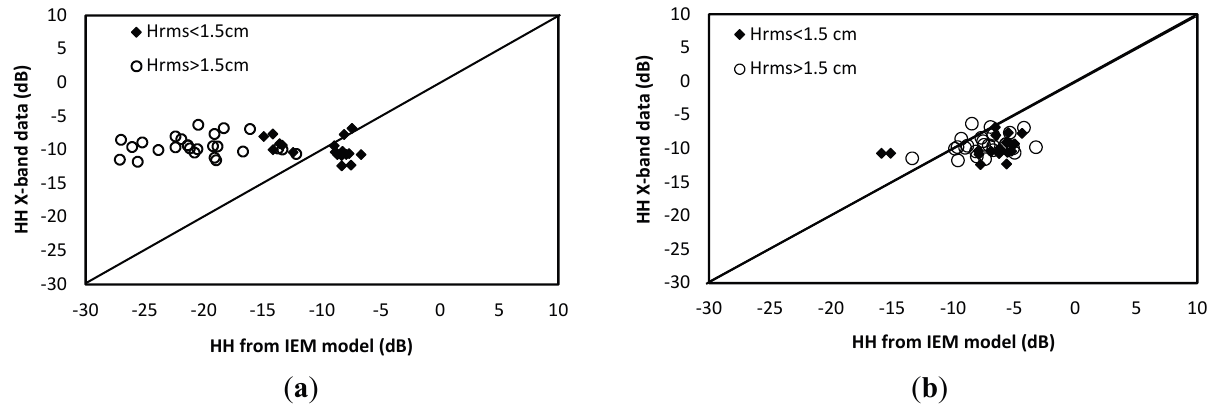
Figure 9. Comparison between measured X-band data and IEM simulations at 26° incidence in the HH polarization: ( a ) exponential correlation surface; ( b ) Gaussian correlation function. Using X-band data and various incidence angles in the range between 25° and 52°, Baghdadi et al. , [30] observed that the IEM correctly simulates the values of σ 0 HH and σ 0 VV for the following two cases: Hrms < 1.5 cm with an exponential correlation function; and Hrms >1.5 cm with a Gaussian